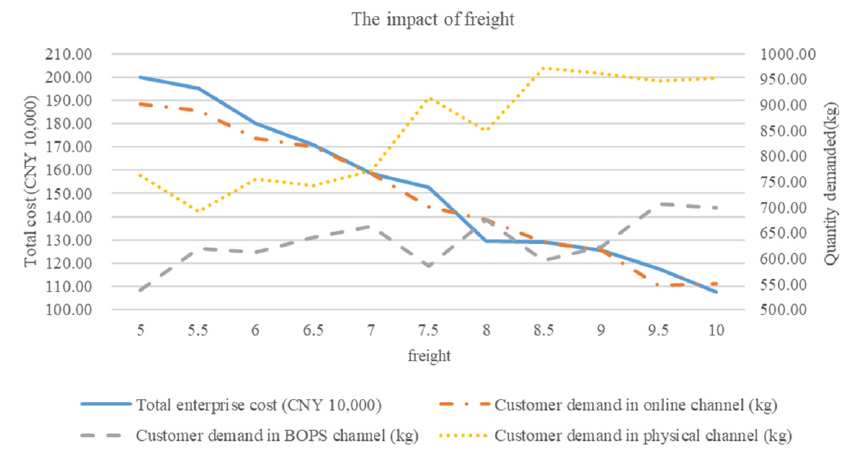
Figure 4. Freight sensitivity analysis. As can be seen from Figure 4, with the increase in freight level, the total enterprise cost tends to decline, and customer demand in the online channel gradually decreases, while customer demand in the BOPS channel and offline physical channel generally shows an upward trend. The lower the demand for the online channel, the lower the logistics and distribution cost of the enterprise, and the lower the penalty cost of return, thus reducing the total enterprise cost. It can be concluded that the higher the freight level set by the enterprise, the more customers’ demands in the online channel will be transferred to the BOPS channel and the offline physical channel, which is conducive to reducing the total enterprise